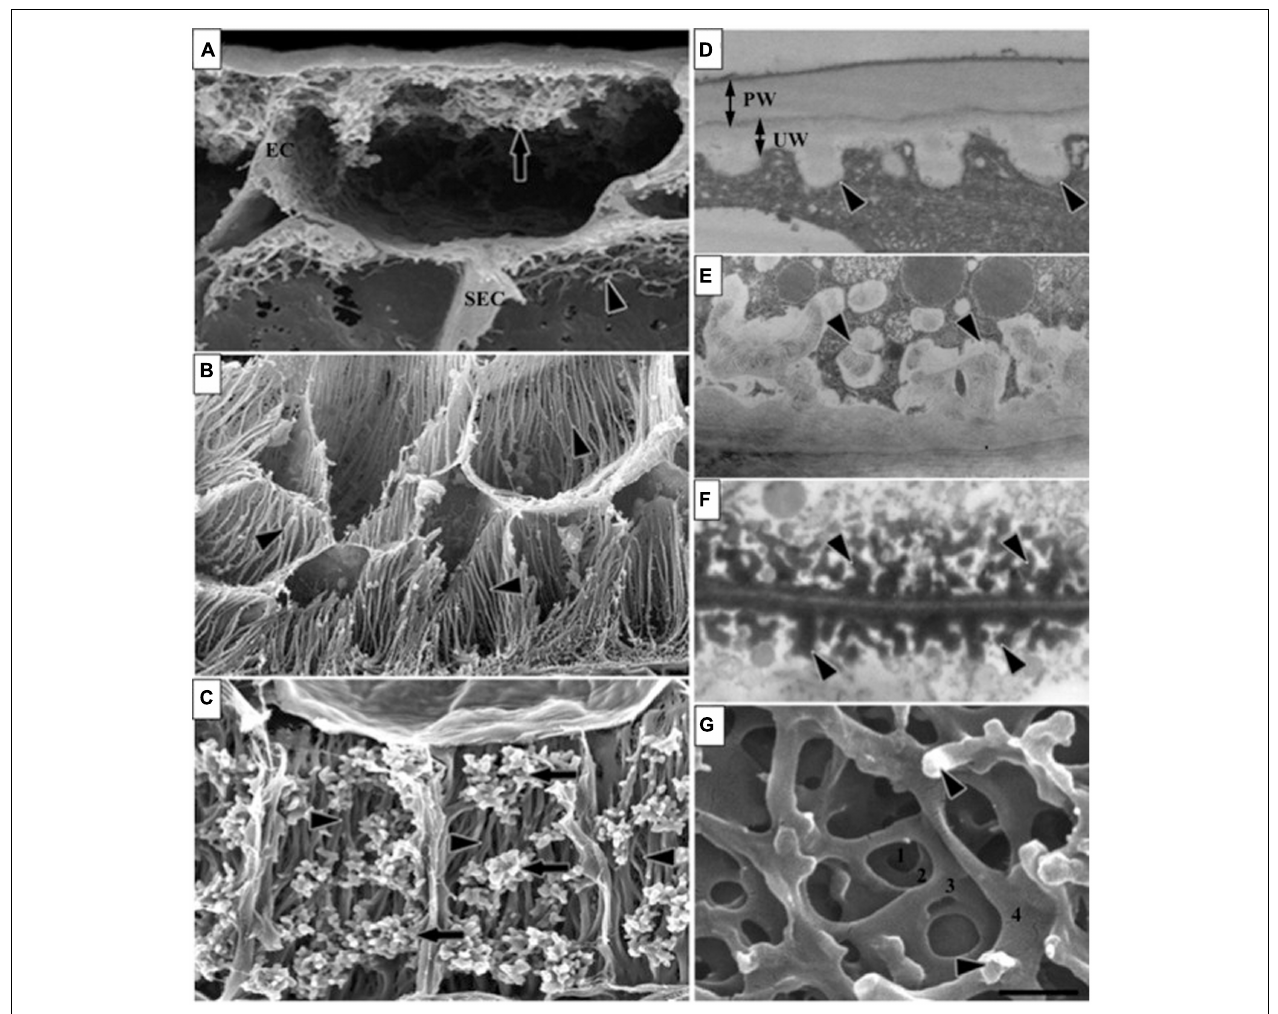
induced to trans-differentiate to a transfer cell morphology displaying primary wall (PW) and uniform walls (UW). (E) Small papillate ingrowths (darts) of a seed coat transfer cell of V. faba exhibiting reticulate architecture. (F) Antler-shaped reticulate wall ingrowths (darts) of a nucellar projection transfer cell of a developing Triticum turgidum var. durum seed (modified after Wang etal., 1994). (G) Field emission scanning electron microscope image of the cytoplasmic face of the reticulate ingrowth wall labyrinth of an abaxial epidermal transfer cell of a V. faba cotyledon following removal of the cytoplasm and dry cleaving (for method seeTalbot etal. (2001), image modified afterTalbot etal. (2001)) where the darts indicate ingrowth papillae on the most recently deposited wall layer. Single scale bar for (A,B) = 2.5 μ m; for (C) = 5 μ m; for (D,E) = 1 μ m; for (F) = 0.25 μ m; for (G) = 0.5 μ m. Figure legend and images reproduced with permission from Andriunas etal. (2013).